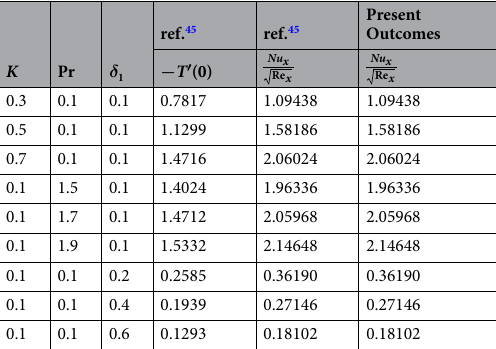
Table 7. LNN comparison with ref. 45 .